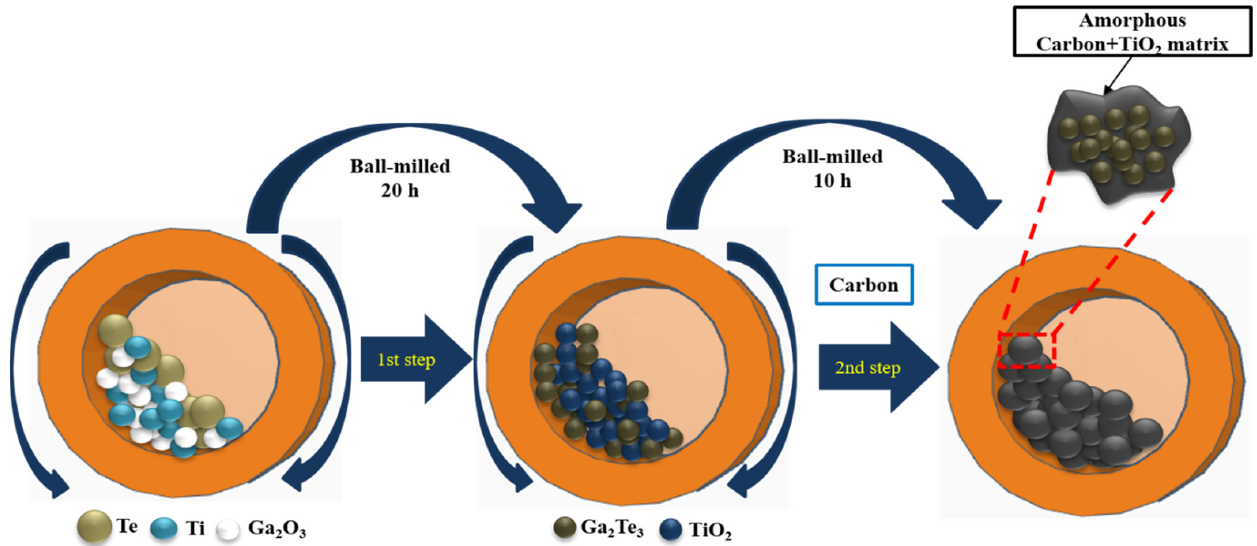
Figure 1. Schematic of Ga 2 Te 3 -TiO 2 -C synthesis using two-step HEBM process.